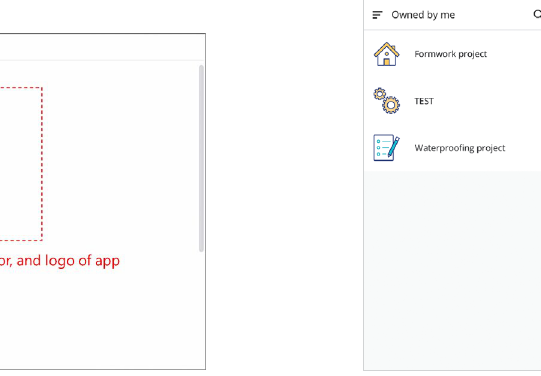
Figure 22. App selection screen